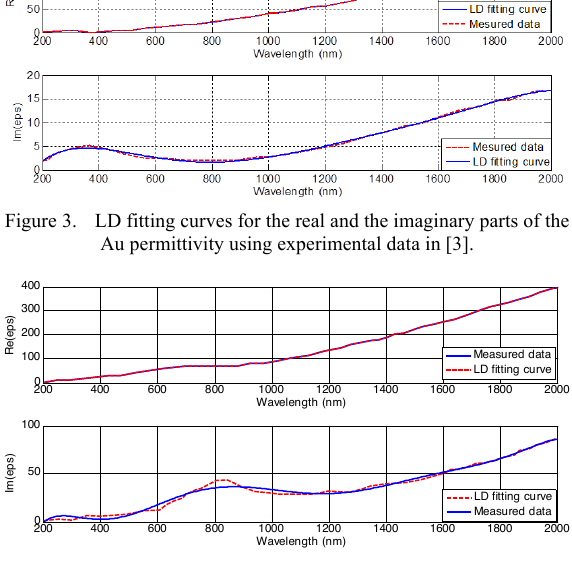
Figure 4. LD fitting curves for the real and the imaginary parts of the Al permittivity using experimental data in [4].